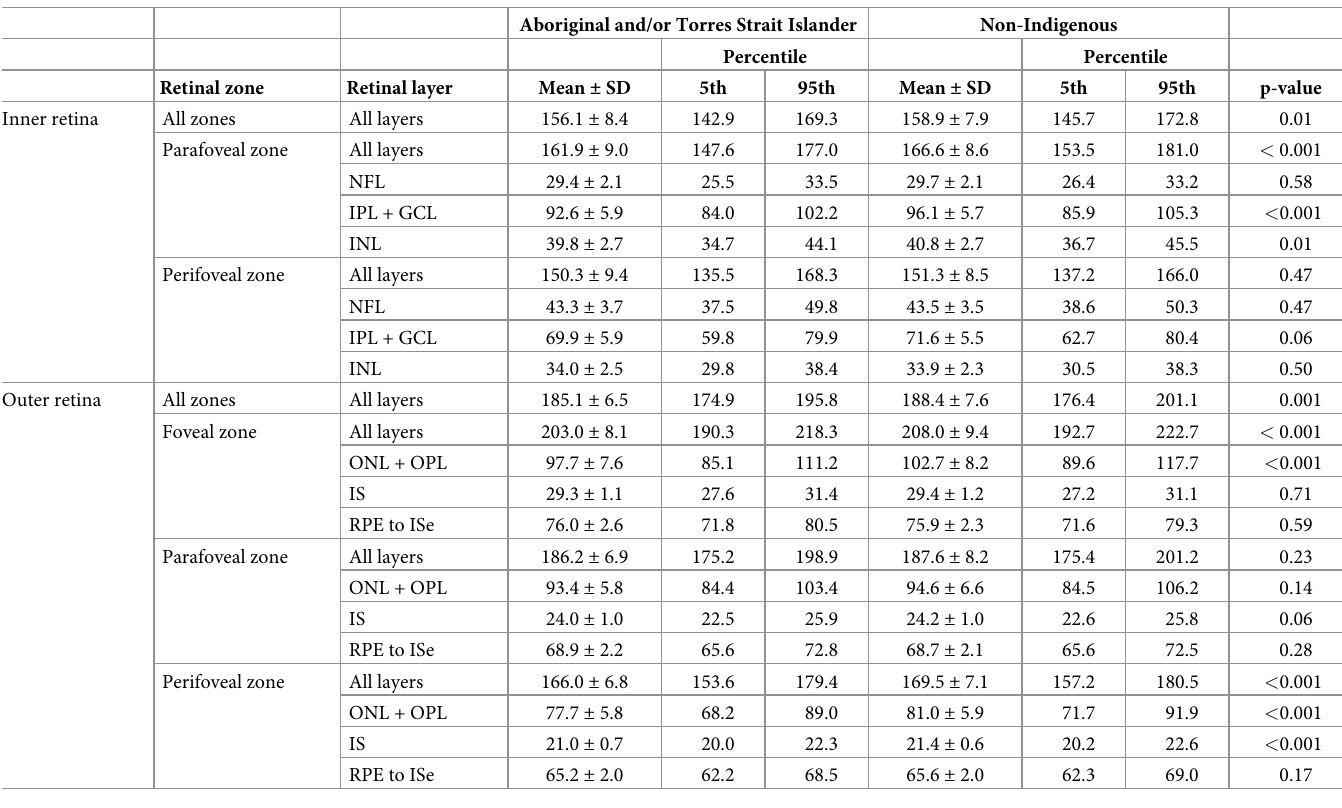
Table 4. Retinal thickness measurements of each retinal layer within the inner and outer retina, by retinal zone, and comparisons by Indigenous